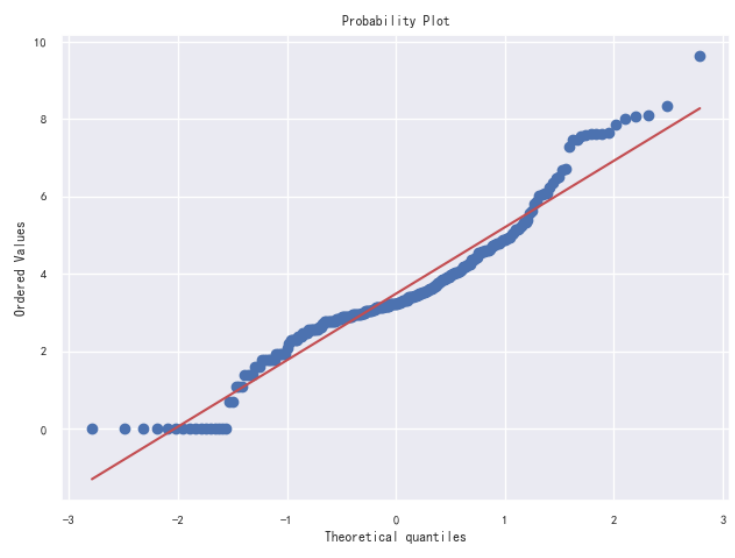
Figure 8. Diagnosis numbers Q-Q diagram after data